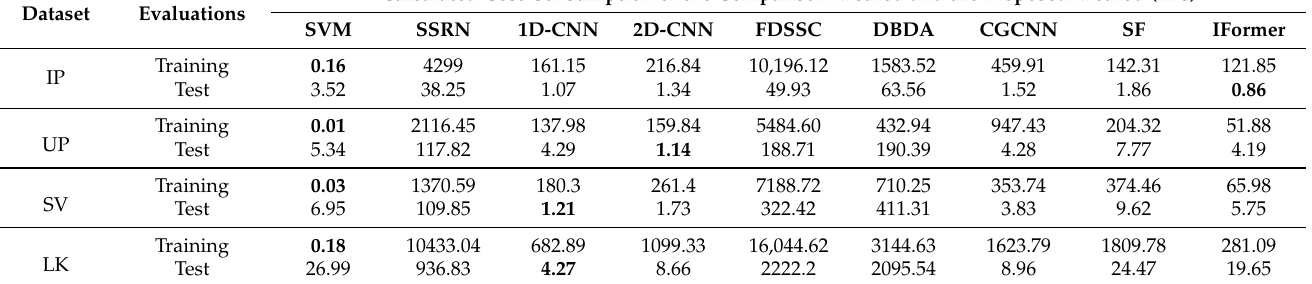
Table 9. Comparing the computational cost consumption of different methods with the proposed method on four HSI datasets.